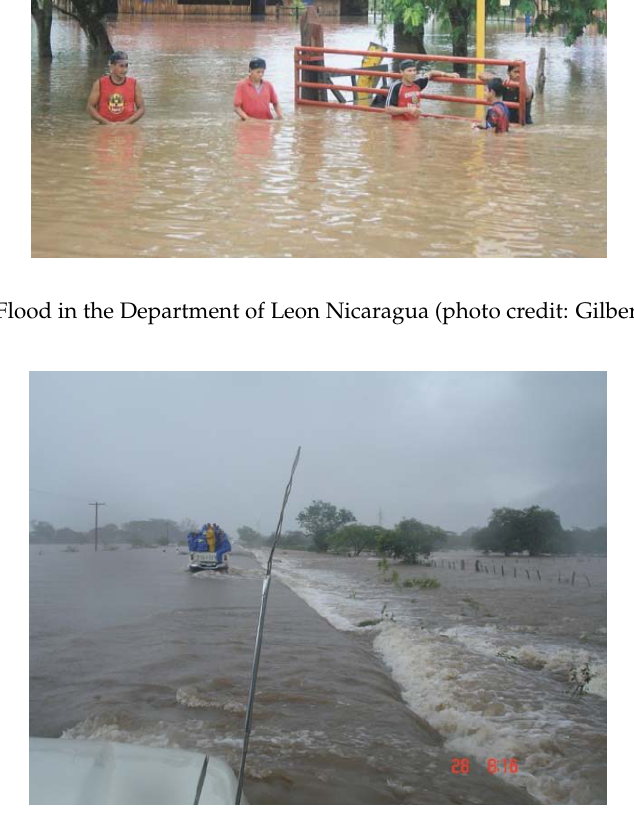
Figure A2. Road after a flood in Leon, Nicaragua (photo credit: Gilberto Moreno).